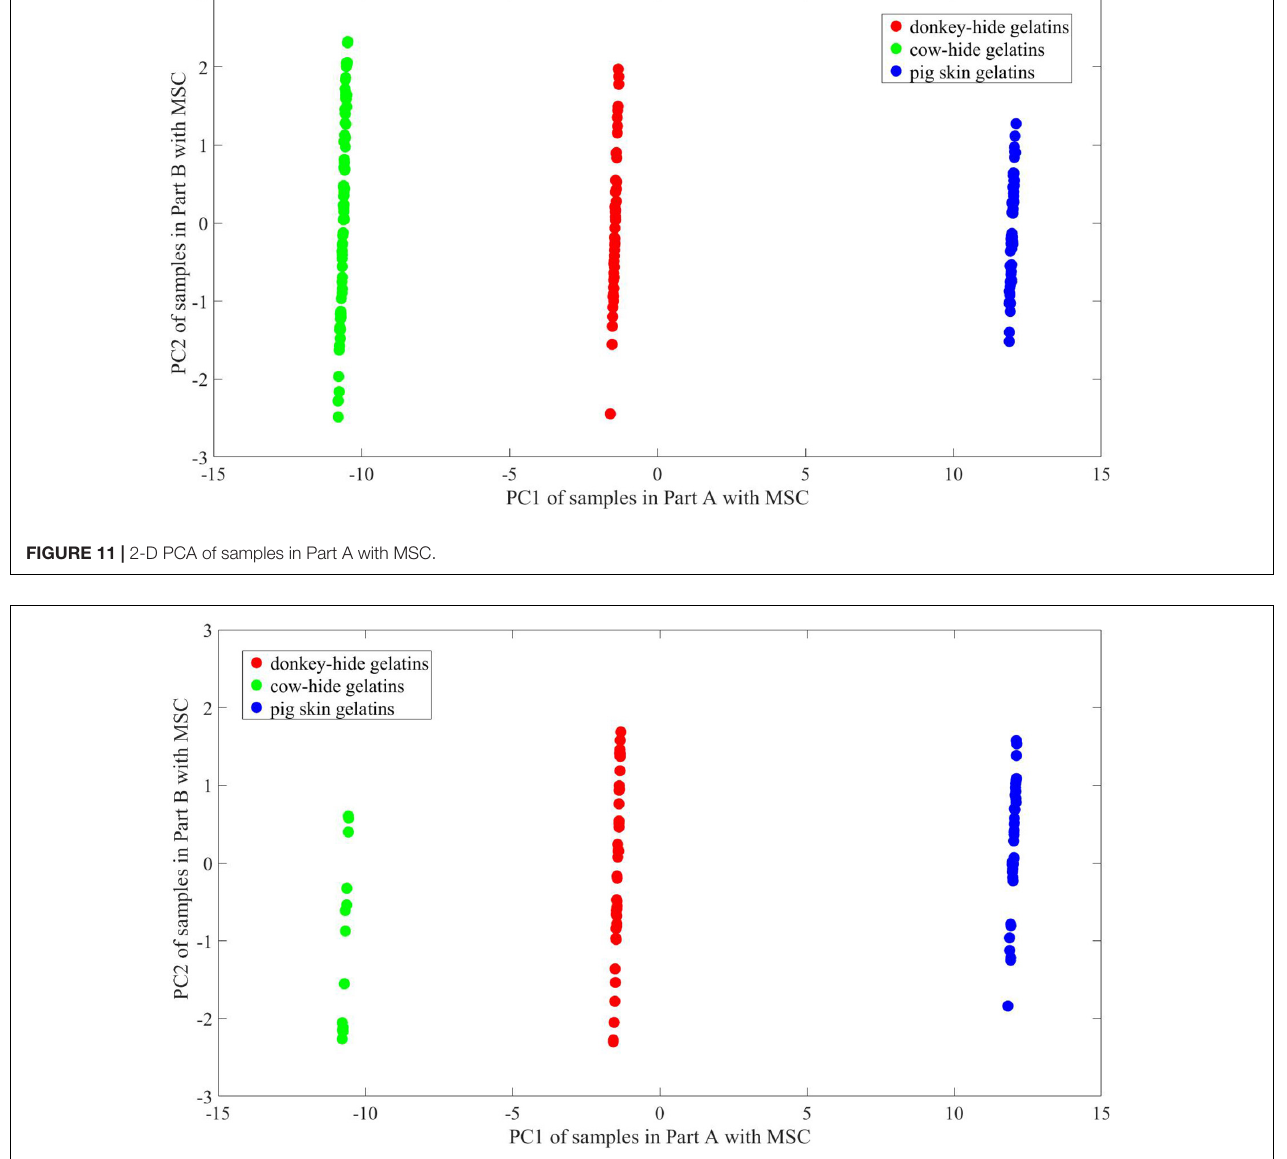
FIGURE 12 | 2-D PCA of samples in Part B with